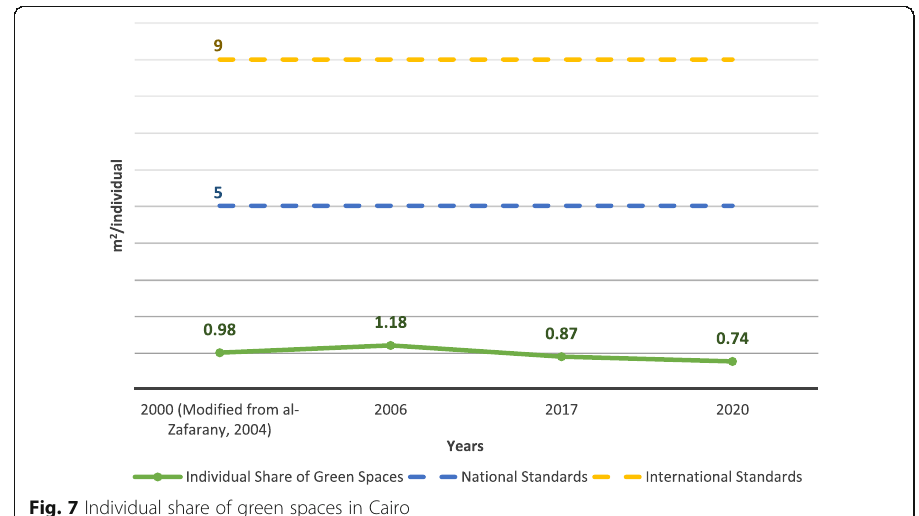
Fig. 7 Individual share of green spaces in